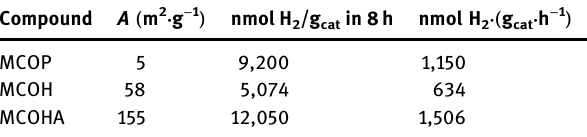
Table 6: Performance of the MCO synthesized by di ff erent